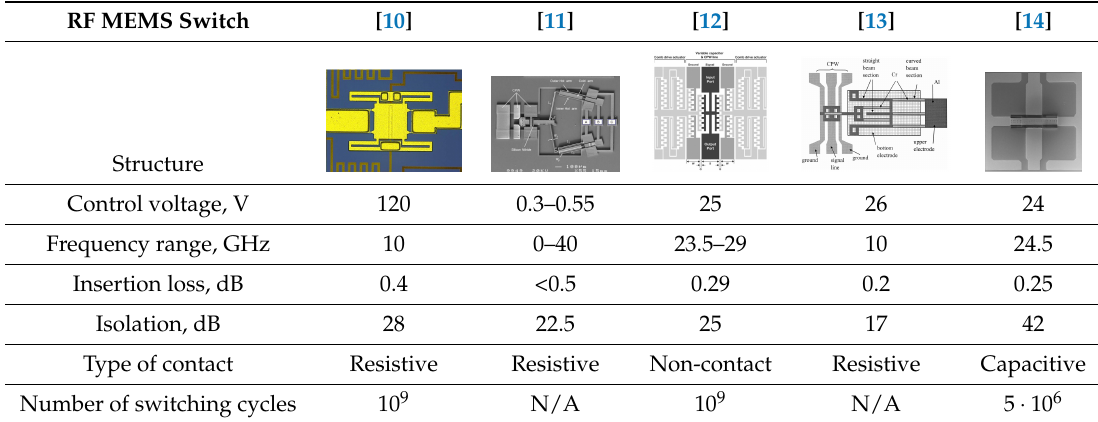
Table 1. Examples of radio-frequency (RF) microelectromechanical systems (MEMS) switch designs. RF MEMS